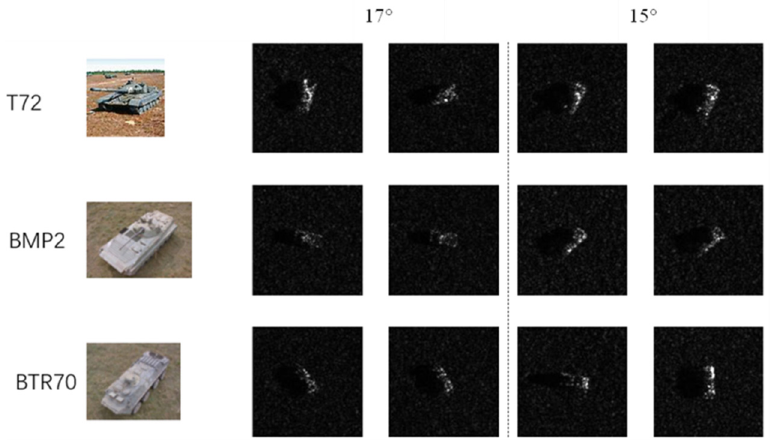
Figure 6. Multi-angle images of three types of vehicle targets.